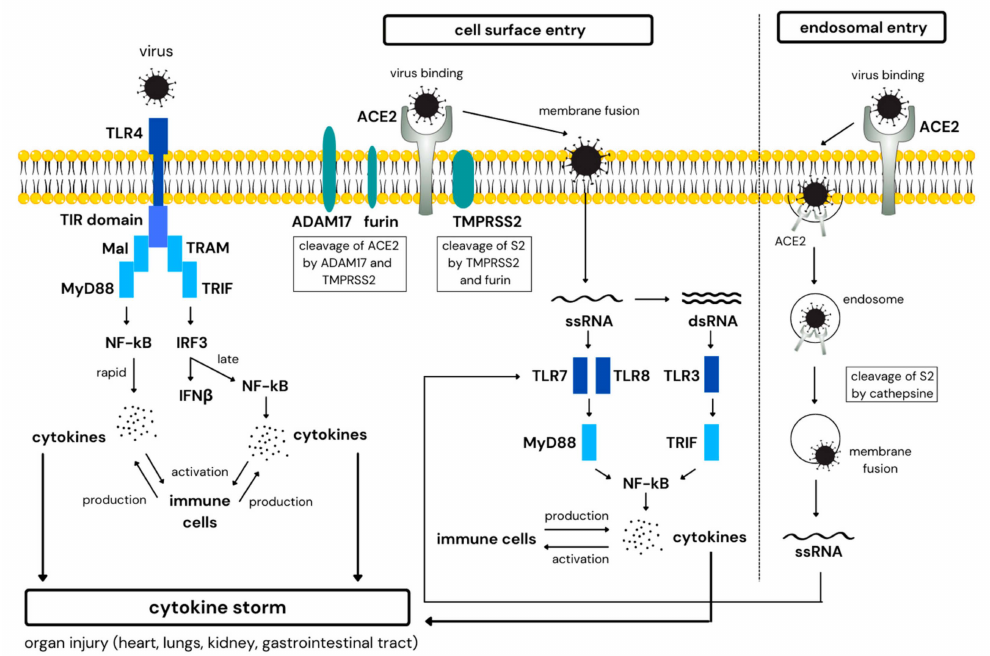
Figure 1. Mechanism of cytokine storm development in COVID-19. ACE2—angiotensin-converting enzyme 2, ADAM17—A disintegrin and metalloproteinase 17, dsRNA—double-stranded